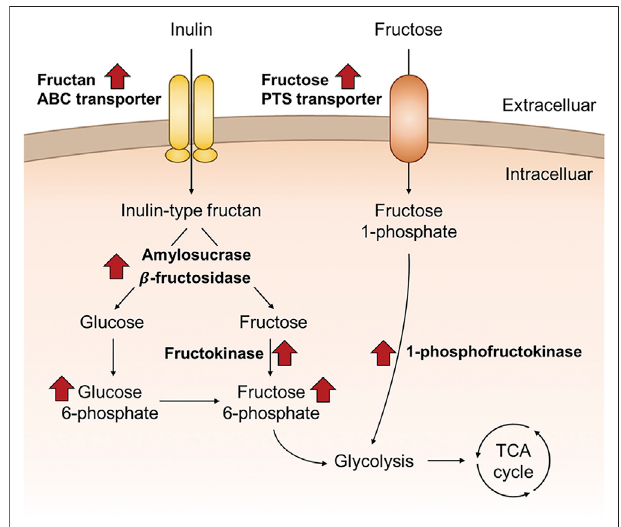
FIGURE 8 | Schematic overview of the proposed inulin utilization pathway of F. prausnitzii that were discovered in this study, based on the proteomic and metabolomic data of F. prausnitzii grown on inulin relative to